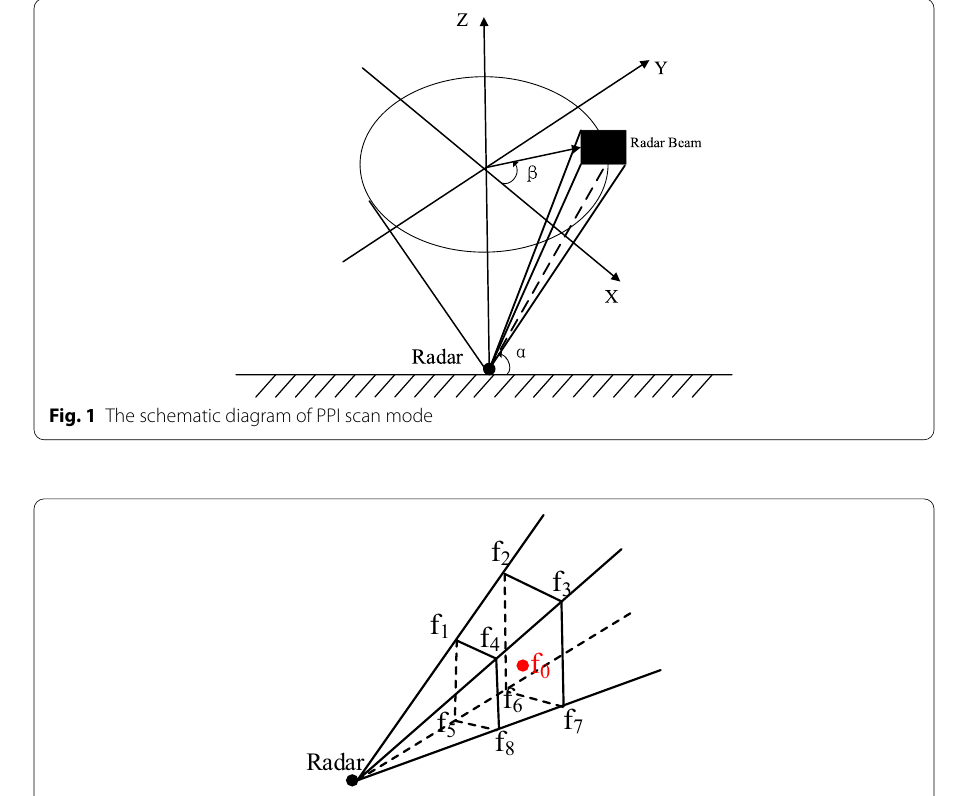
Fig. 2 An illustration of adaptive Barnes